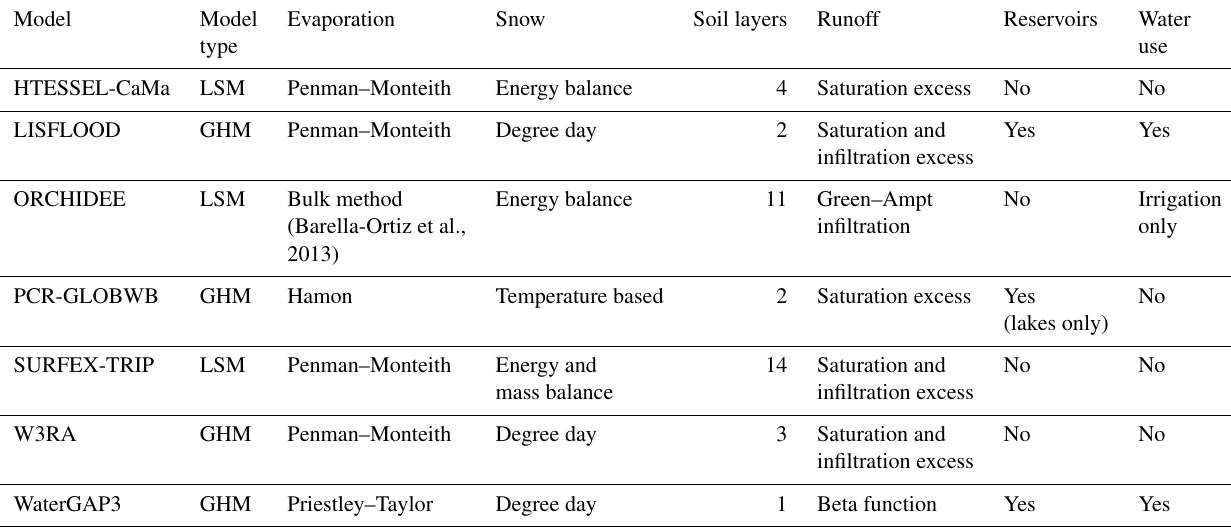
Table 1. Overview of models and relevant characteristics.